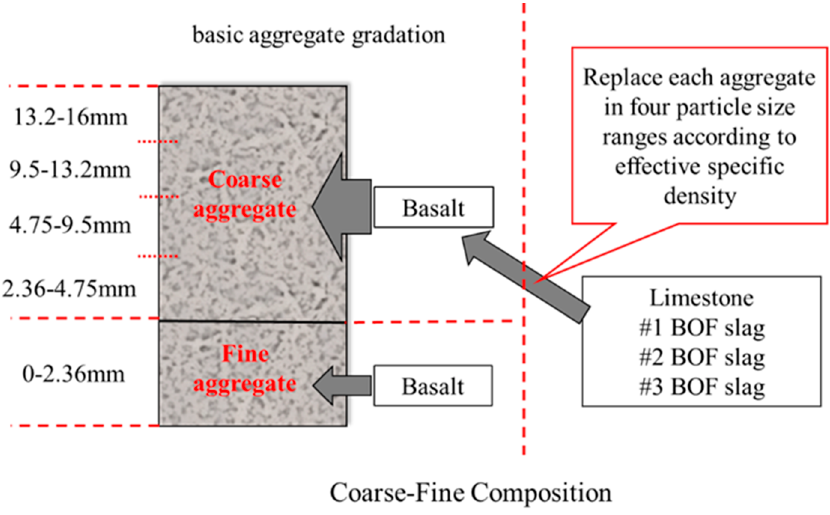
Figure 3. The coarse–fine composition method.